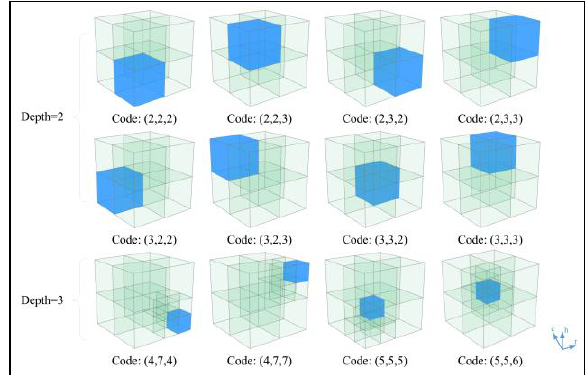
Figure 2. Cube Index Code of octree nodes